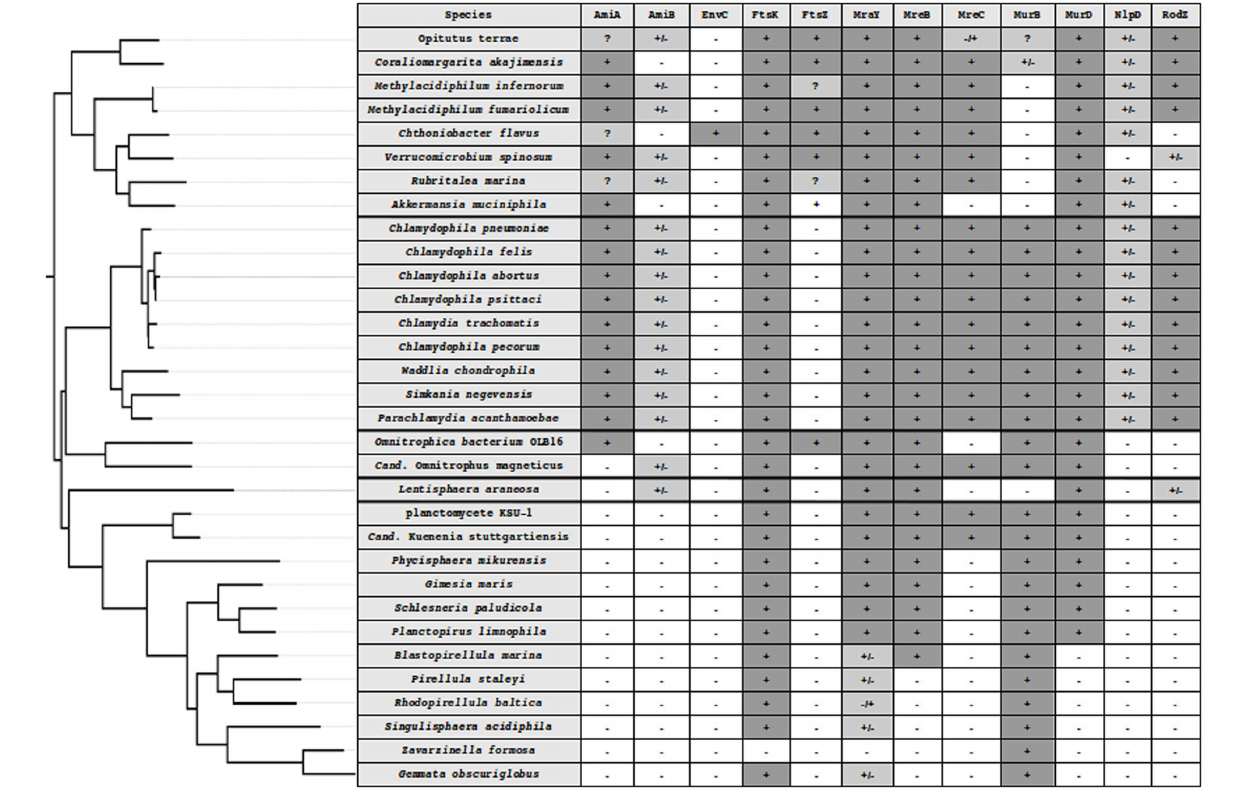
FIGURE 1 | Phylogenetic tree of the PVC superphylum and detection of division and PG synthesis-related proteins in PVC. PVC species from five well-supported monophyletic groups, Verrucomicrobia , Lentisphaera , Chlamydiae , Planctomycetes, and Cand . Omnitrophica. The tree was built using 16S rRNA sequences in PhyML 3.1 with custom parameters and the HKY85 matrix (Guindon et al., 2010) and rooted on E. coli . In silico protein detection in the PVC proteomes is denoted by the following symbols: − , not found; + , found from both searches; + / − , found in the search starting from the W. chondrophila sequence but not from the one starting from E. coli ; − / + , found in the search starting from the E. coli sequence but not from the one starting from W. chondrophila ; ?, indicating that a candidate could be found using an alternative query (as in the case of Methylacidiphilum infernorum FtsZ), that only a fragment of the protein could be found (incomplete data, as in the case of Rubritalea marina FtsZ) or that both searches found different proteins that were the reciprocal best hit of both queries (as in the case of AmiA in Verrucomicrobia